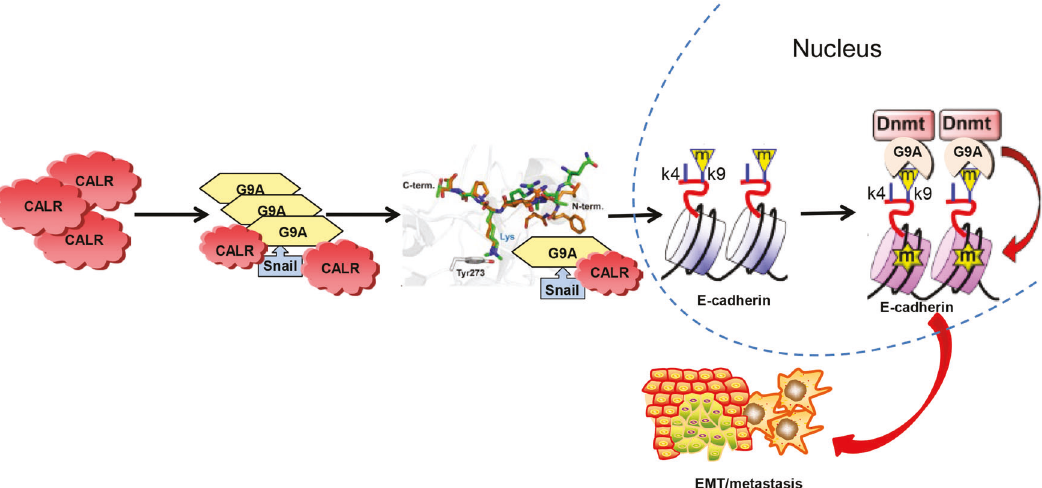
Fig. 6 A schematic model depicting to illustrate the interaction of Snail with G9a and DNMTs leading to E-cadherin promoter methylation and EMT induction. G9a-mediated H3K9me2 can provide a docking site for the Dnmt complex, which results in DNA methylation at the E-cadherin